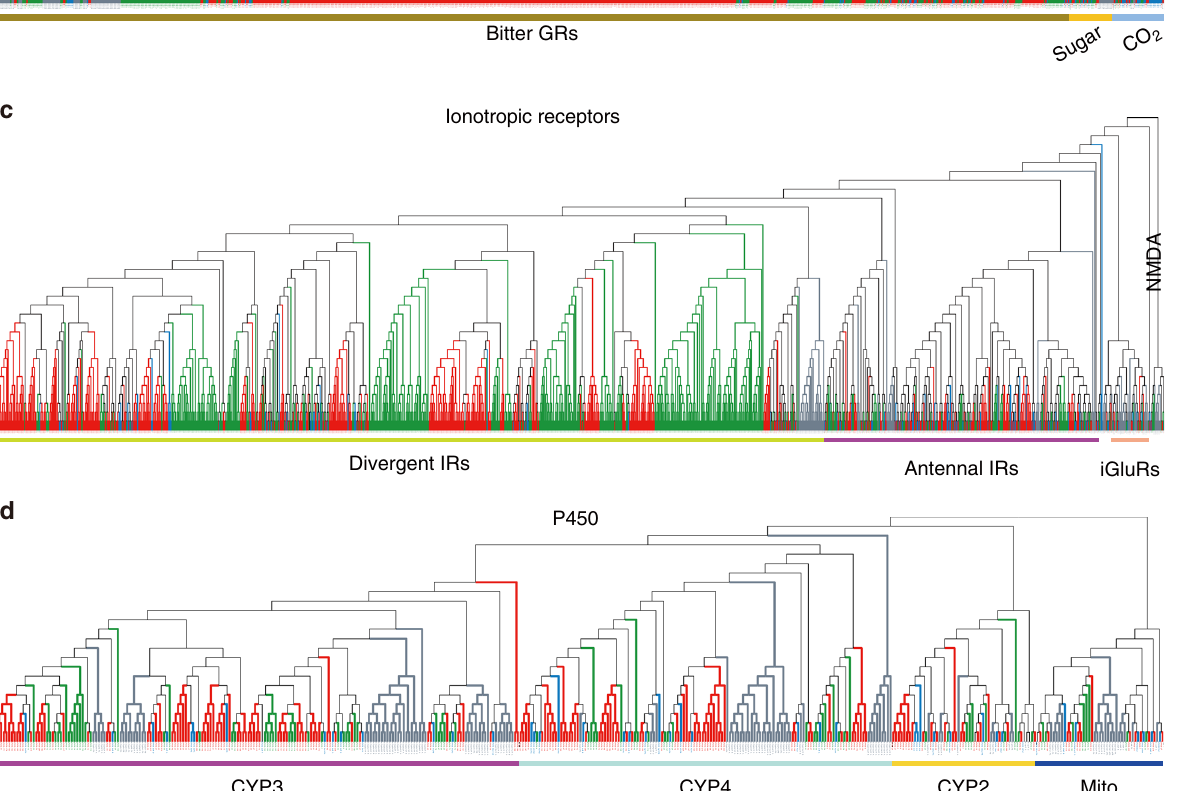
Fig. 2 Gene families involved in chemoreception and detoxi fi cation in P. americana and other blattodean species. a Counts of chemosensory- and detoxi fi cation-related gene families in the genomes of three blattodean species and Drosophila melanogaster . OR olfactory receptor, GR gustatory receptor, IR ionotropic receptor, OBP odorant-binding protein, P450 cytochromes P450 (CYP), CCE carboxyl/choline esterases, GST glutathione S -transferase, ABC ATP-binding cassette. Of these, three gene families with massive expansions in P. americana were selected for maximum-likelihood phylogenetic analysis, as shown in b – d , representing GRs, IRs, and P450, respectively. Phylogenetic relationships of other gene families are shown in Supplementary Figs. 3 – 7. iGluRs ionotropic glutamate receptors, NMDA N -methyl- D -aspartate receptors, Mito the mitochondrial